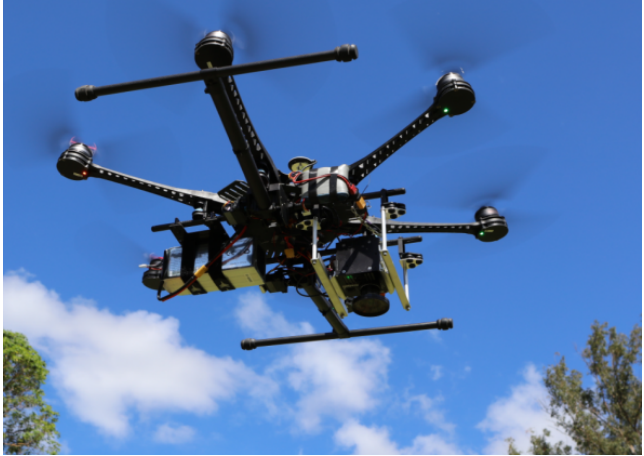
Figure 3. The DJI S800 EVO (DJI, Guangdong, China) unmanned aerial vehicle (UAV) flying in Cape Range National Park, Western Australia (WA),